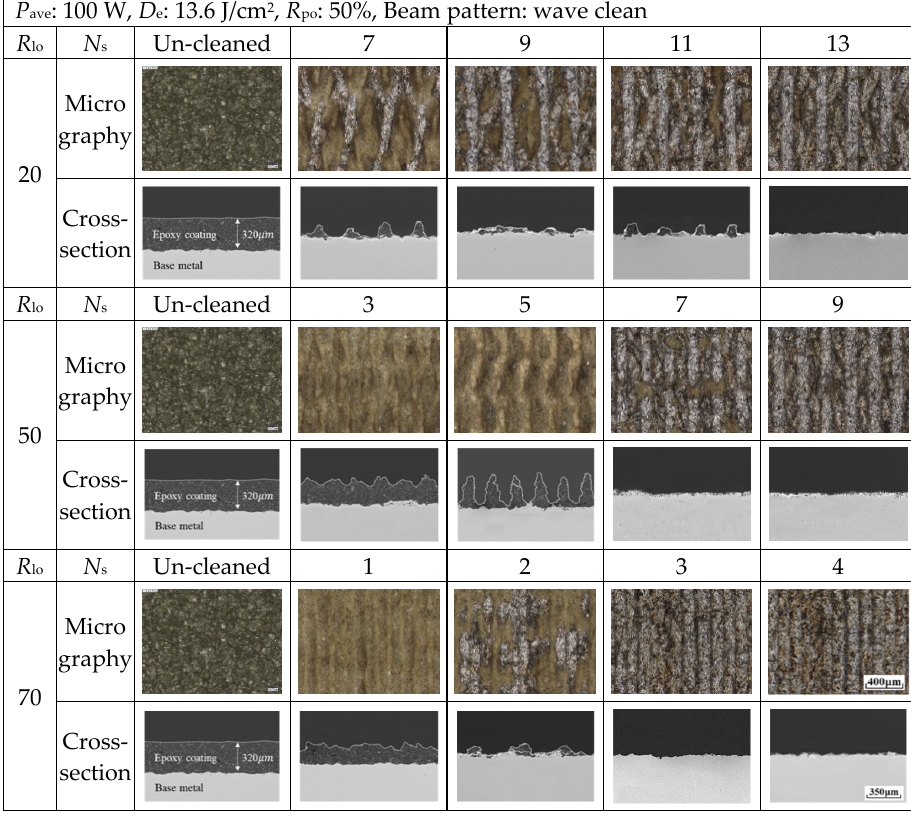
Figure 10. Variation of roughness in the laser-cleaned surfaces according to the line overlap rates.